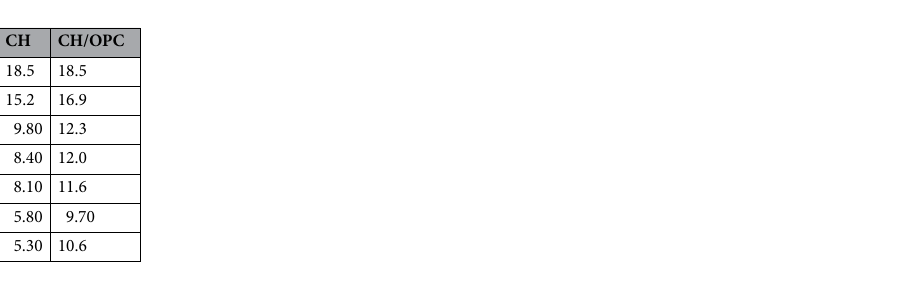
Table 9. Amount of calcium hydroxide (C–H) with respect to the content of binder and OPC after 91